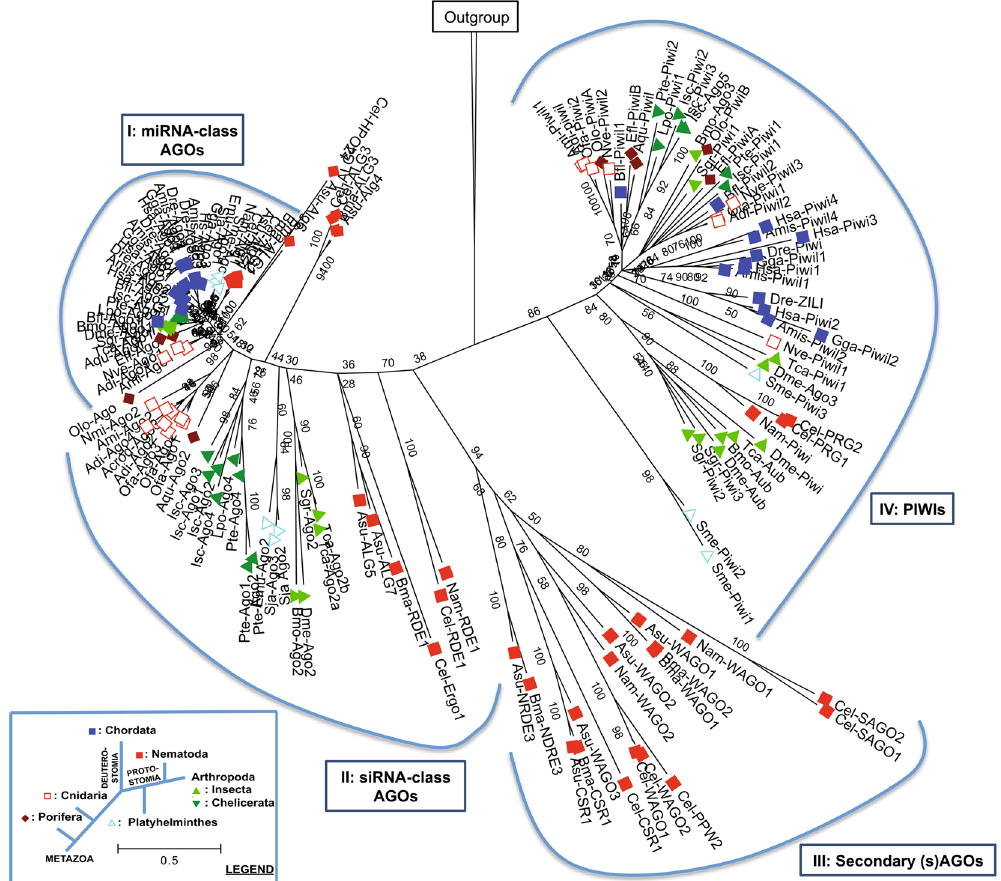
Figure 1. Rooted maximum likelihood phylogenetic tree (100 bootstraps) using the most conserved region between Argonaute superfamily members belonging to Porifera ( : Amphimedon queenslandica ; Aqu, Ephydatia fluviatillis ; Efl, Oscarella lobularis ; Olo), Cnidaria ( : Acropora digitifera ; Adi, Acropora millepora ; Ami, Orbicella faveolata ; Ofa, Nemastella vectensis ; Nve), Chordata ( : Homo sapiens ; Hsa, Alligator mississippiensis ; Ami, Gallus gallus ; Gga, Danio rerio ; Dre, Brachiostoma floridae ; Bfl), Nematoda ( : Caenorhabditis elegans ; Cel, Ascaris suum ; Asu, Brugia malayi ; Bma, Necator americanus ; Nam), Arthropoda (Insecta: : Drosophila melanogaster ; Dme, Bombyx mori ; Bmo, Tribolium castaneum ; Tca, Schistocerca gregaria ; Sgr, and Chelicerata: : Ixodes scapularis ; Isc, Parasteatoda tepidariorum ; Pte, Limulus polyphemus ; Lpo) and Platyhelminthes ( : Echinococcus multilocularis ; Emu, Schistosoma japonicum ; Sja, Schmistea mediterranea ; Sme). Detailed information on the sequences used is presented in Suppl. Table S2. The Argonaute superfamily can be dissected into four distinct groups: (I) miRNA-class AGOs, (II) siRNA-class AGOs, (III) Secondary (s)AGOs and (IV) PIWI